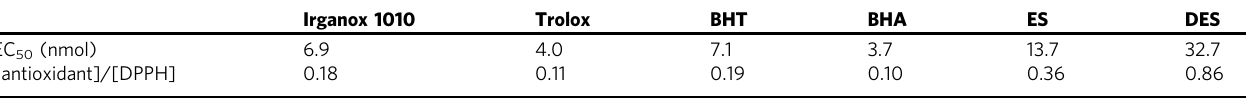
Table 2 Antioxidant